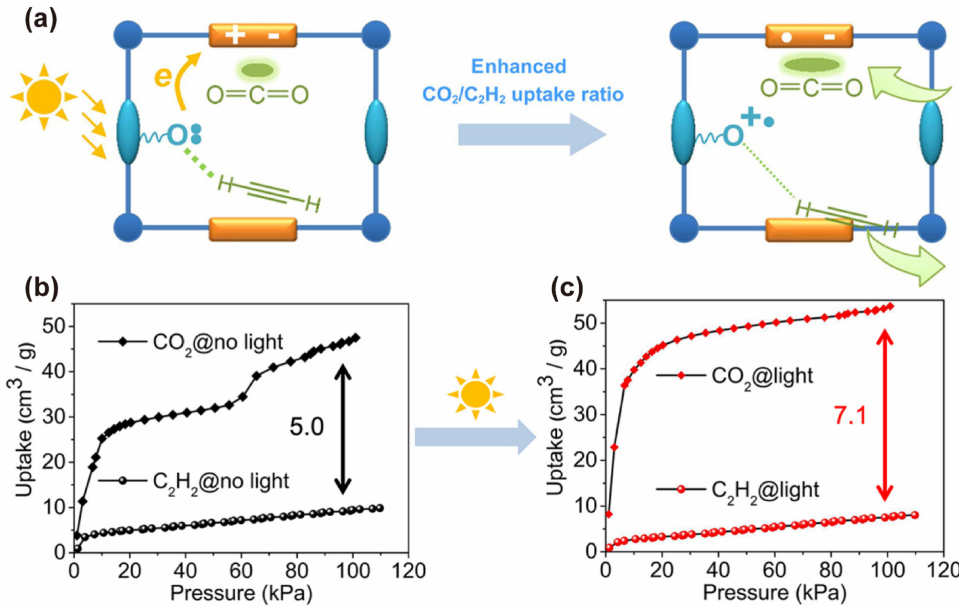
Figure 8. ( a ) PIET strategy for improving the uptake ratio of CO 2 /C 2 H 2 . ( b , c ) Adsorption isotherms of C 2 H 2 and CO 2 before ( b ) and after ( c ) irradiation at 273 K. Reproduced with permission from Cai et al., Angewandte Chemie International Edition; published by John Wiley and Sons, 2021 [79]. Pore chemistry can also be optimized through a precise steric arrangement of inter- action sites for favorable CO 2 adsorption on the pore surface. Gu et al. demonstrated the strategy of “opposite action” in MOFs, realizing the CO 2 selective adsorption and separa- tion of CO 2 /C 2 H 2 under ambient temperature and pressure [74]. They synthesized two isostructural MOFs, PCP-NH 2 -bdc and PCP-NH 2 -ipa, from meso- α , β -di(4-pyridyl) glycol) (dpg), terephthalic acid (bdc) and isophthalic acid (ipa). Owing to the different electronic structures of CO 2 and C 2 H 2 , they tended to exhibit different binding orientations when adsorbed in microporous channels. Therefore, the precise encoding of interaction sites (-NH 2 ) parallel to the CO 2 binding site in the channel could enhance the CO 2 –framework interaction without significantly changing the adsorption orientation of the CO 2 molecules.